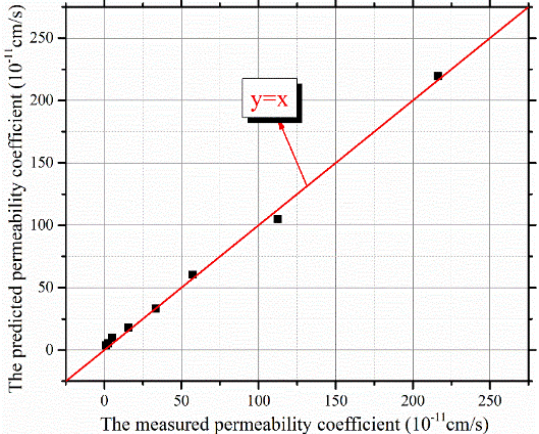
Figure 16. The predicted permeability coefficients from fractal analysis versus the measured permeability coefficients. Red solid line indicates a slope of 1:1. The closer the black point is to the line, the smaller the difference between the predicted and measured permeability coefficient is.